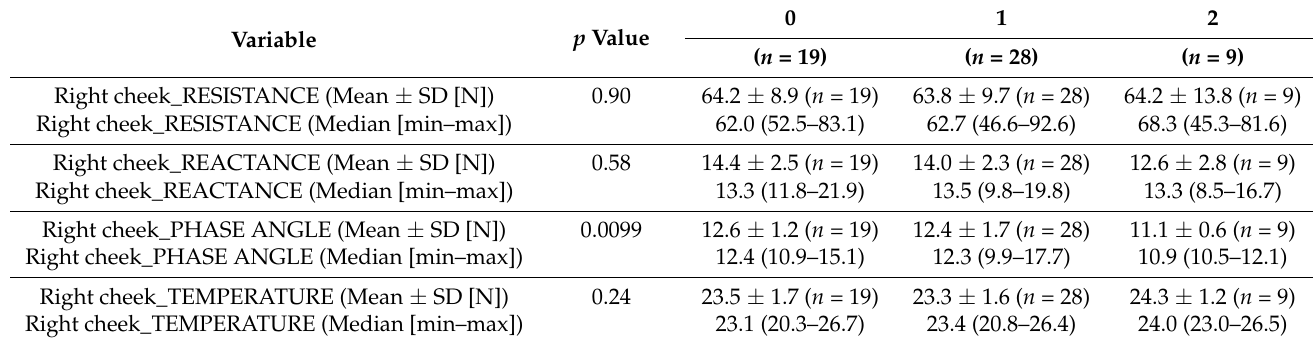
Table 3. Comparison between measurements in different types of lesion in OLP patients (right cheek), classified as: no lesions = 0; striations = 1; erythema or erosion = 2. Electrical values are in Ohm. 1 = Wilcoxon’s rank-sum test.